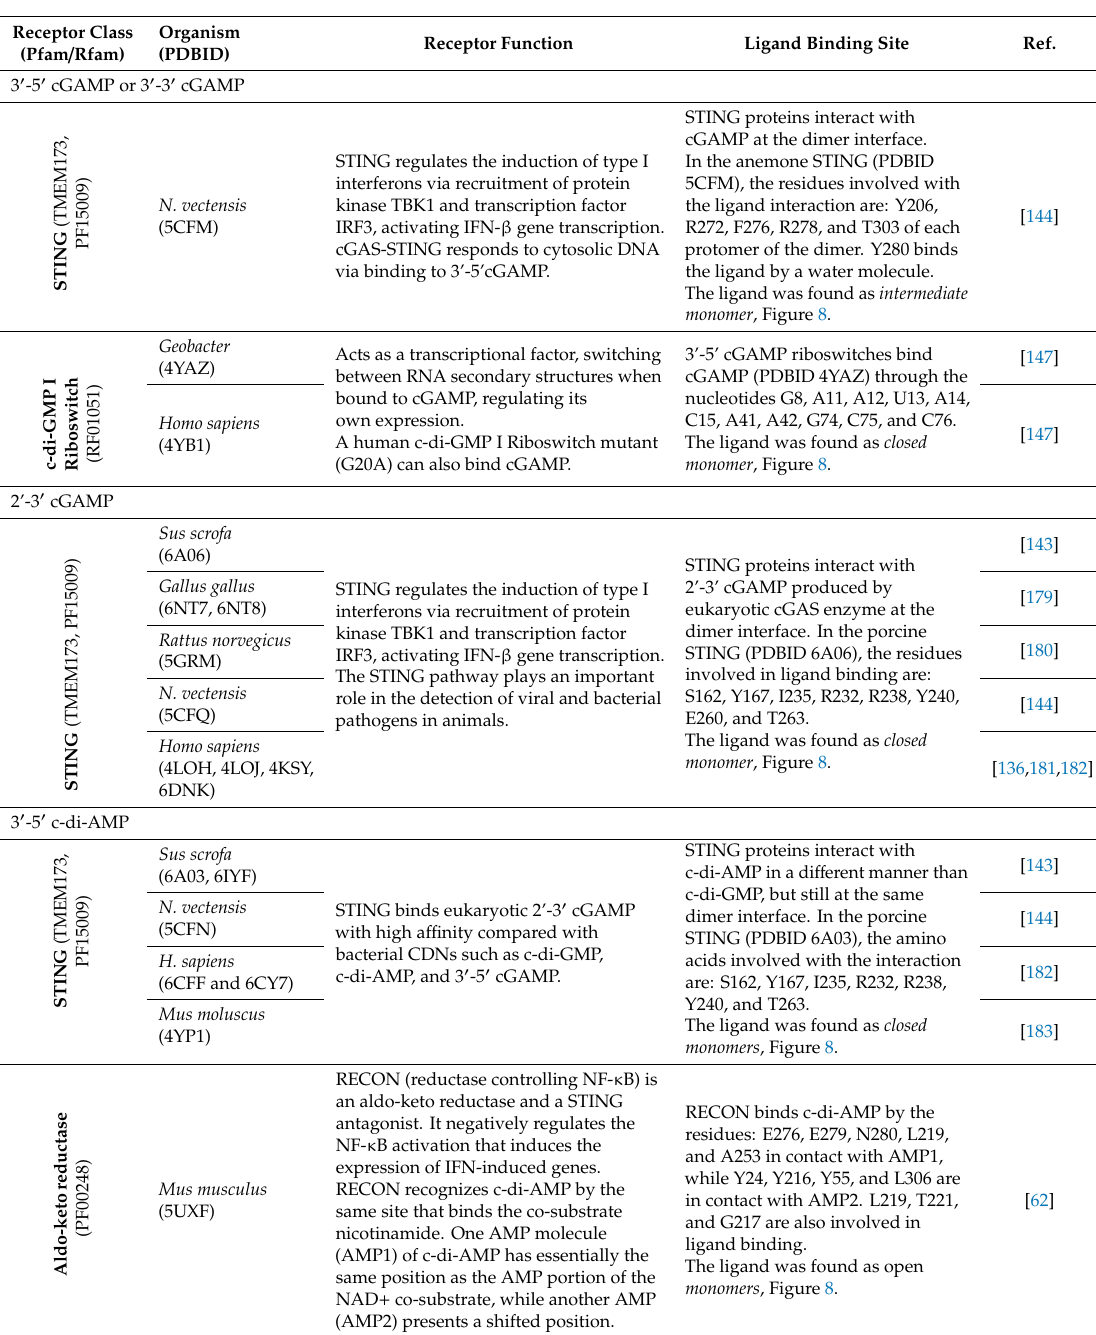
Receptor Function Ligand Binding Site